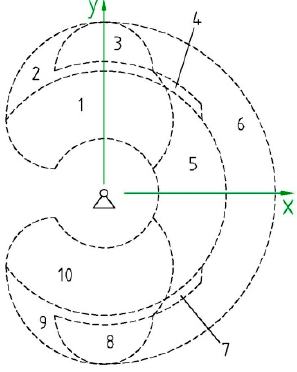
Figure 17. Mapping the robot’s workspace according to the type of solution.